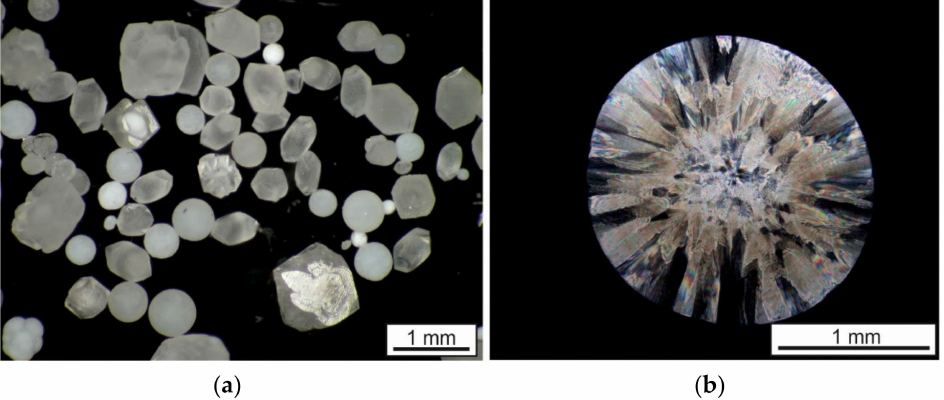
Figure 8. Influence of reagent concentration on the character of the product: ( a ) Crystals of calcite with CaCl 2 and Na 2 CO 3 concentrations set to 0.25 mol/L; ( b ) Radial spherulites (cross-section, crossed polars) are the only product with 0.05 mol/L reagent concentration in use.